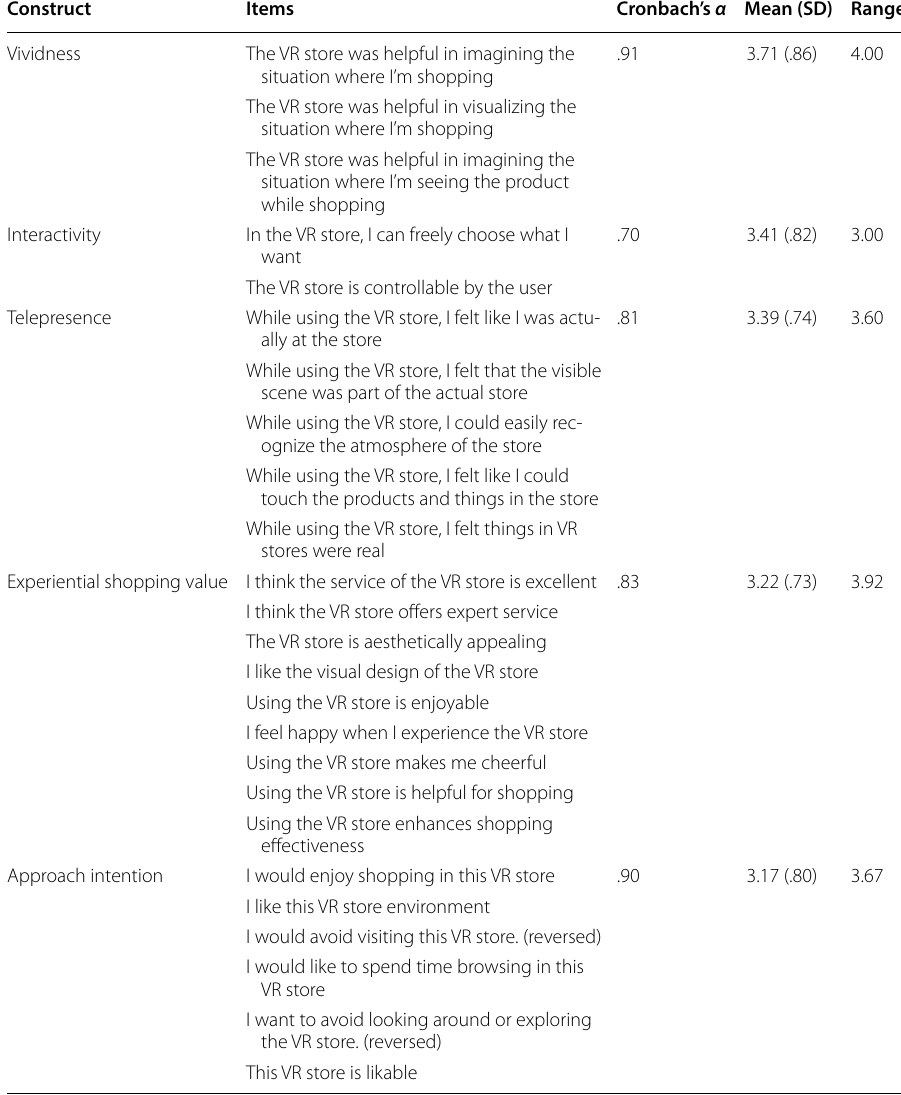
Table 1 Measurements’ reliability and descriptive statistics Construct